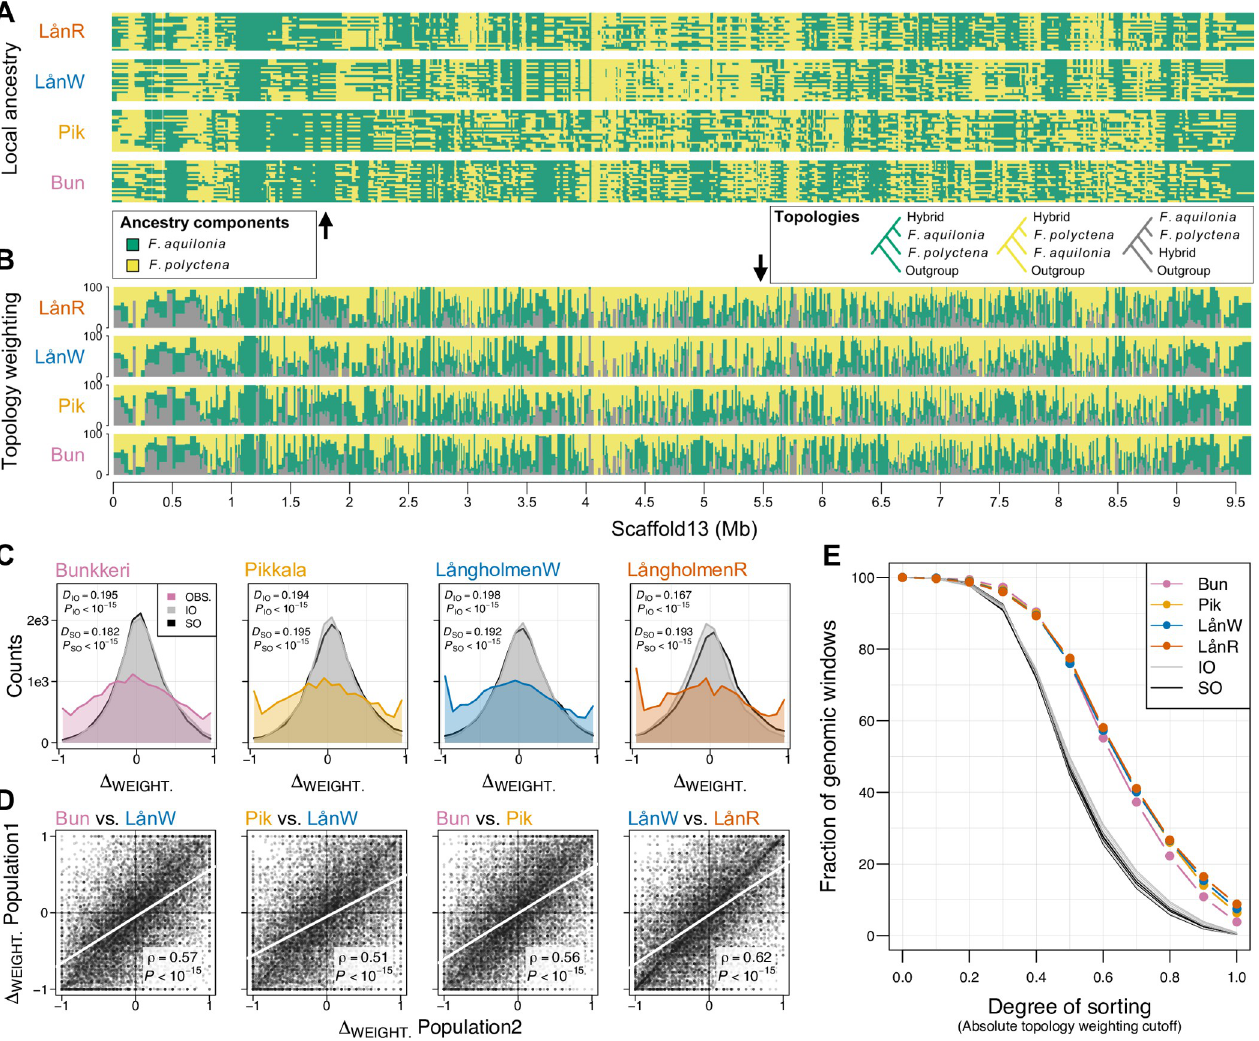
Fig 2. Sorting of genetic variation is more correlated than expected under neutrality across 3 hybrid wood ant populations. Examples of (A) local ancestry and (B) topology weighting patterns (green: hybrids locally related to F . aquilonia , yellow: hybrids locally related to F . polyctena ) inferred independently in each population along 1 pseudo-chromosome (Scaffold 13). (C) Excess of extreme topology weightings in observed compared to simulated data (IO, SO) in all populations. Empirical and simulated distributions compared with two-sample Kolmogorov–Smirnov tests ( D , test statistic and P , P -value). (D) Genome-wide comparison of topology weighting differences between each population pair ( Δ WEIGHT. : F . aquilonia weighting minus F . polyctena weighting, computed per population over 14,890 100-SNP windows, gray circles). The regression line is indicated in white. ρ , Spearman’s correlation coefficient and P , P -value of the Spearman’s correlation test. (E) A larger fraction of the genome is sorted in observed compared to simulated data in all populations (sorting measured as the absolute F . aquilonia or F . polyctena weighting, see S3 Fig for detailed results per pairwise comparison). The data underlying this figure can be found in https:// doi.org/10.6084/m9.figshare.c.6140793.v3. IO, independent origins; SO, single